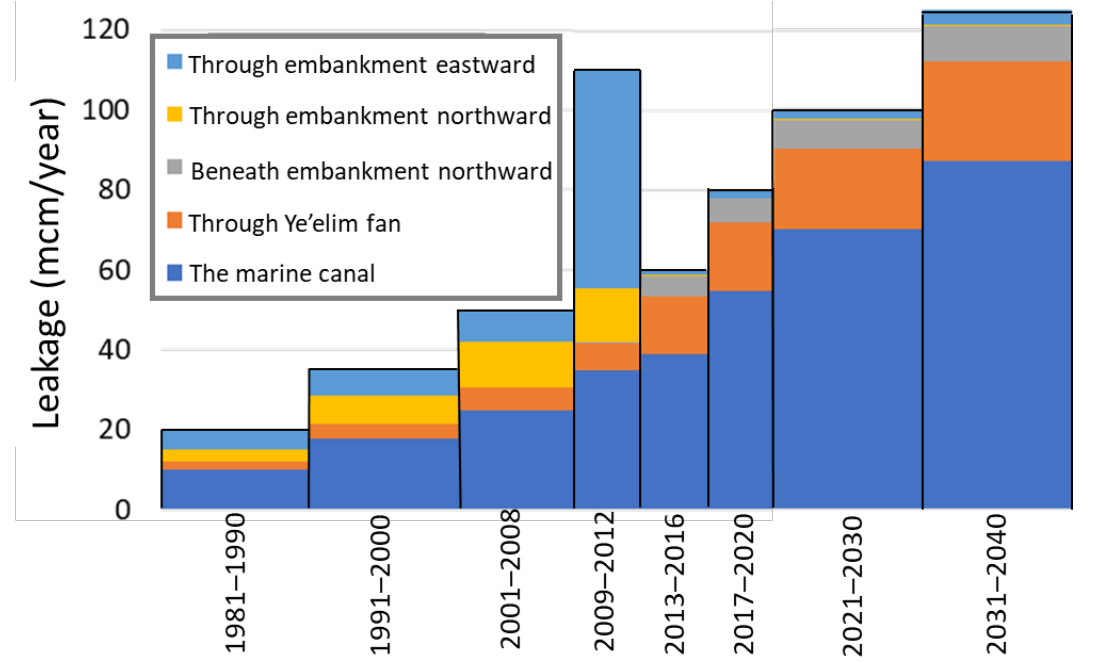
Figure 12. Reconstructed and predicted brine-leakage volumes from the evaporation ponds through different routes in each time period.